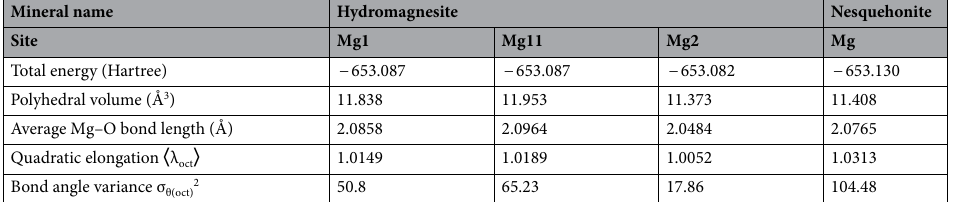
Table 1. Total energy, polyhedral parameters, and distortion indexes of the MgO 6 octahedra in hydromagnesite and nesquehonite. The distortion parameters defined by Robinson et al. 28 are as follows: 6 ( l i / l 0 ) 2 Quadratic elongation 〈 λ oct 〉 = (cid:31) i = 1 6 , where l i is the bond length; l 0 is the center-to-vertex distance for an 12 (θ i − 90 ◦ ) 2 octahedron. Bond angle variance σ θ(oct) 2 = (cid:31) i = 1 11 , where θ i is the O–Mg–O